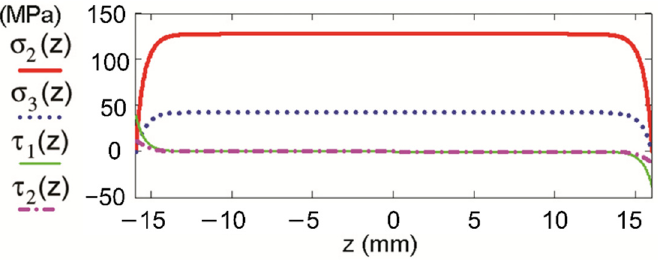
Figure 3. Distribution of normal and shear stresses before cracking in the ceramic surface layer (ceramic hard surface layer).